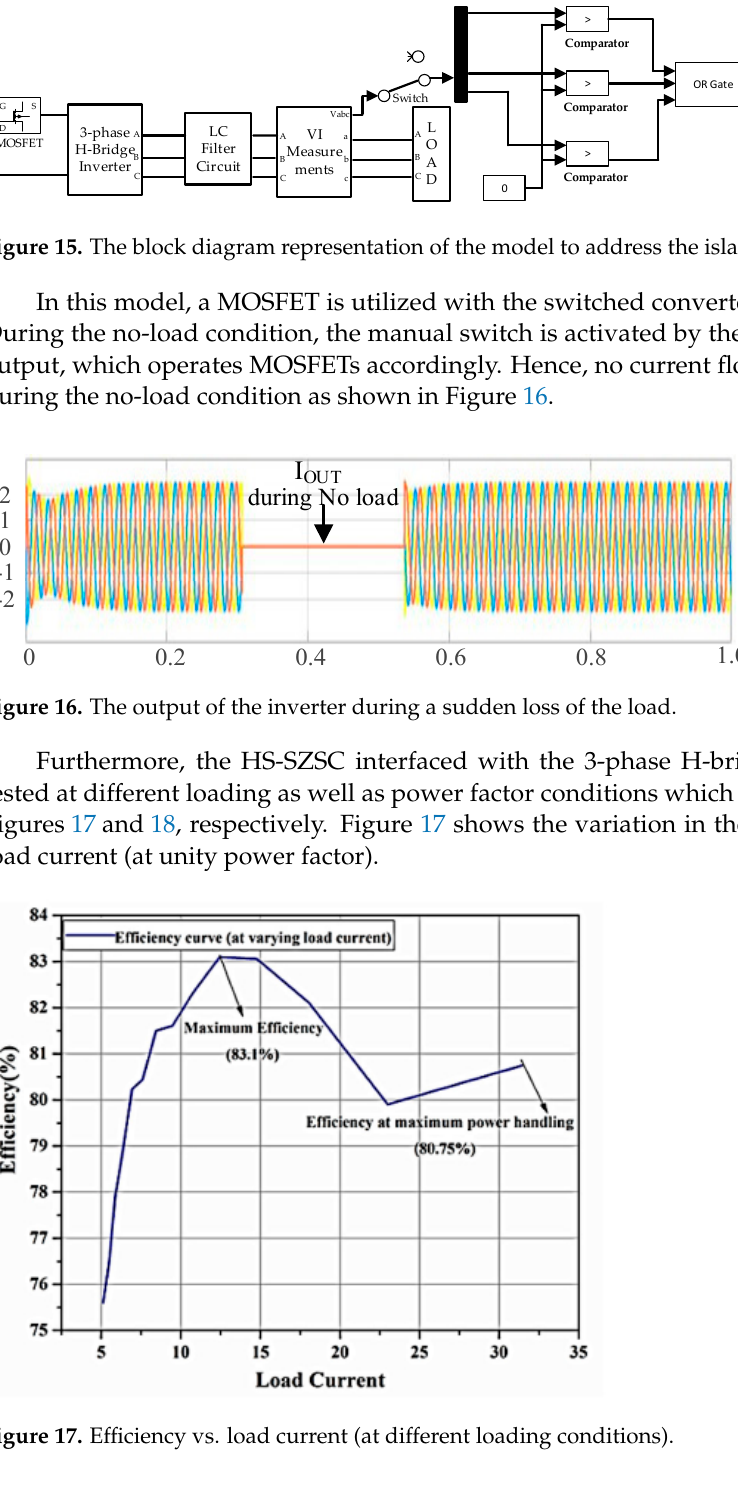
Figure 17. Efficiency vs. load current (at different loading conditions).